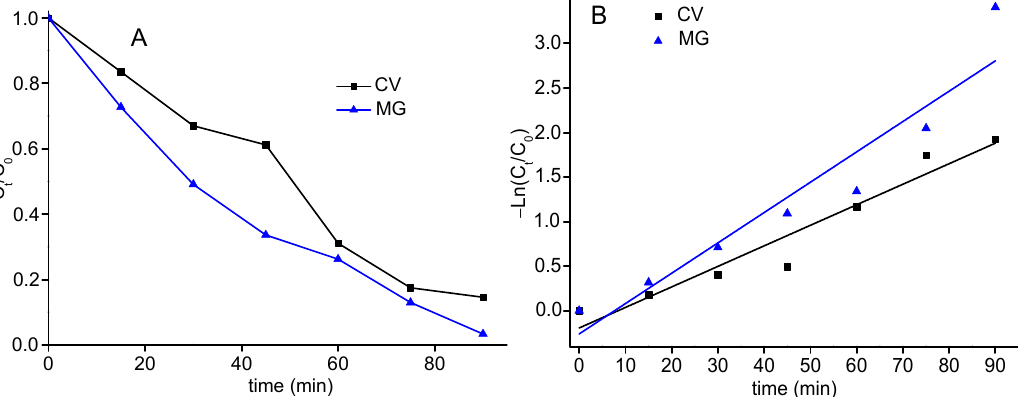
Figure 8. Kinetics of [Co(TMFPP)]-catalysed degradation of malachite green (MG), and crystal violet (CV) through H 2 O 2 in aqueous solution: changes in C t / C 0 versus time ( A ) and changes in ln( C t / C 0 ) versus time ( B ).